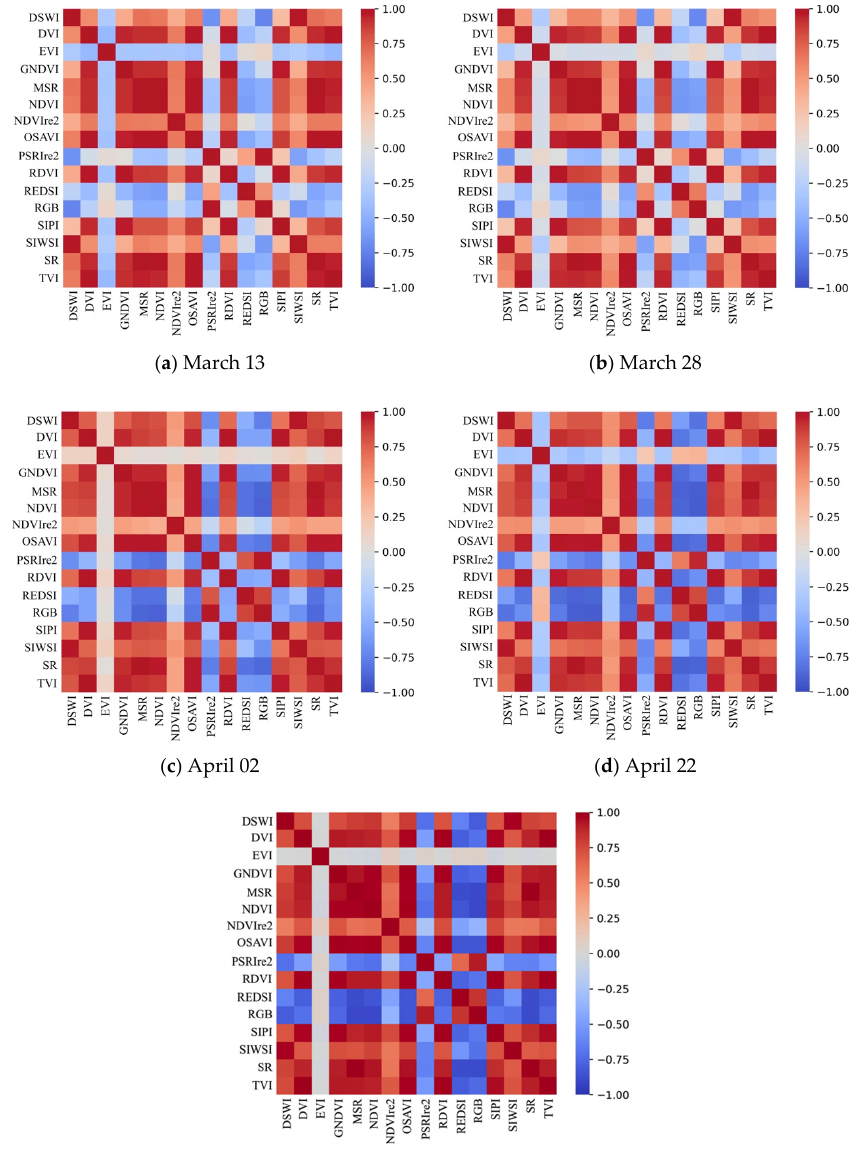
Figure 3. Correlations among the vegetation indices on ( a ) March 13; ( b ) March 28; ( c ) April 02; ( d ) April 22; and ( e ) April 27, calculated by a correlation analysis. Red indicates a positive correlation between the two corresponding vegetation indices, while blue indicates a negative correlation. The darker the color, the more relevant it is to the relationship.